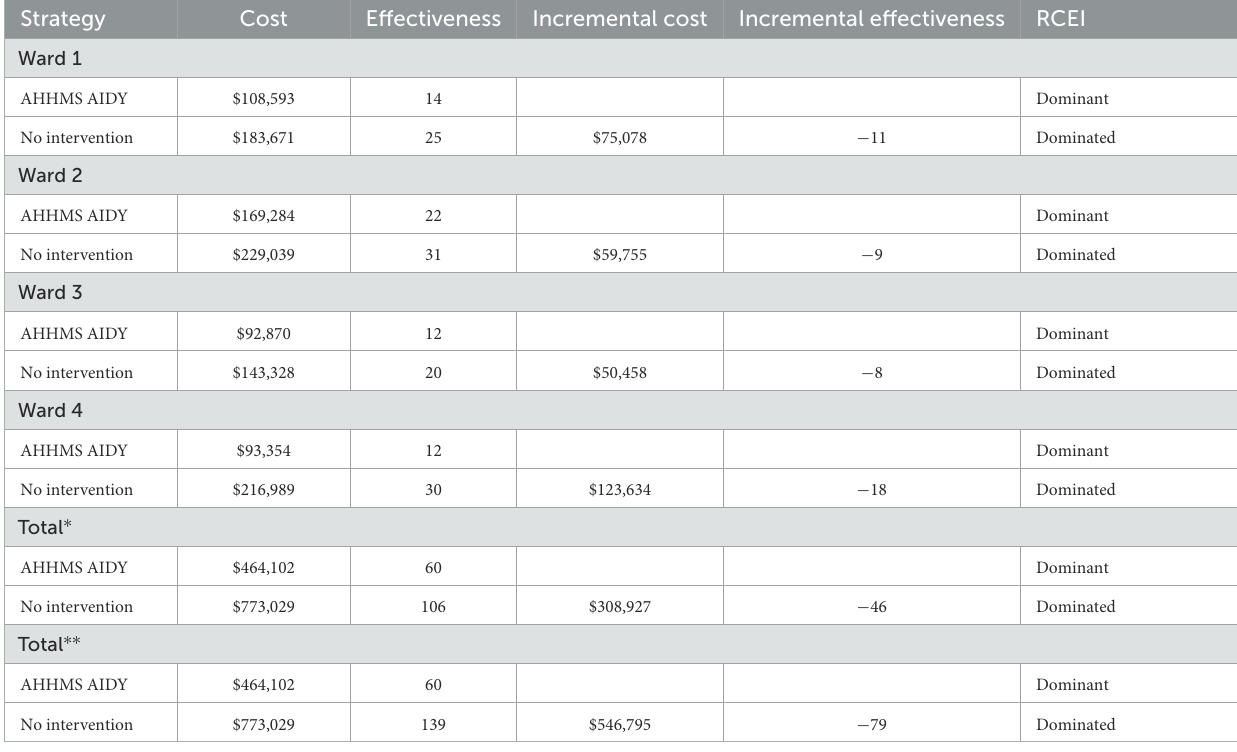
TABLE 5 Cost effectiveness